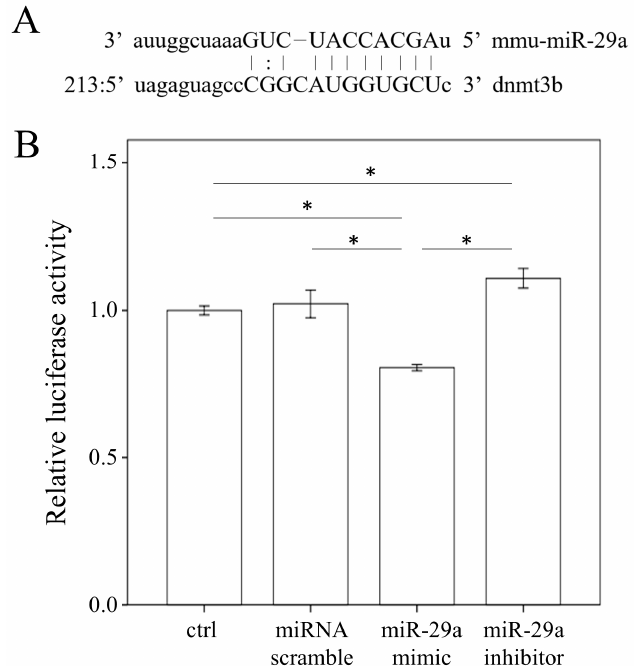
Figure 5. DMNT3b is a direct target of miR-29a. ( A ) Bioinformatic prediction indicates that the seed sequence of miR-29a has a high level of complement to DMNT3b 3 (cid:48) UTR. ( B ) miR-29a mimic transfection into primary hepatic stellate cells inhibited the activity of a luciferase reporter gene linked to the 3 (cid:48) UTR of DMNT3b. Data from six to eight samples per group are expressed as mean ± SD. * indicates a p < 0.05 between the